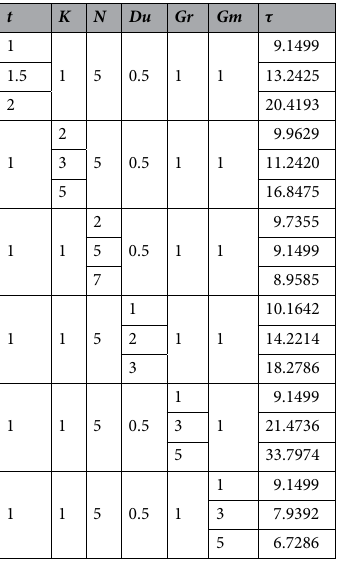
Table 2. Computational values of skin friction for various t, K, N, Du, Gr and Gm when Pr = 0.71, Sc = 0.22, a = 1 , M = 0.5, K* = 0.5, t 1 = 0.5.